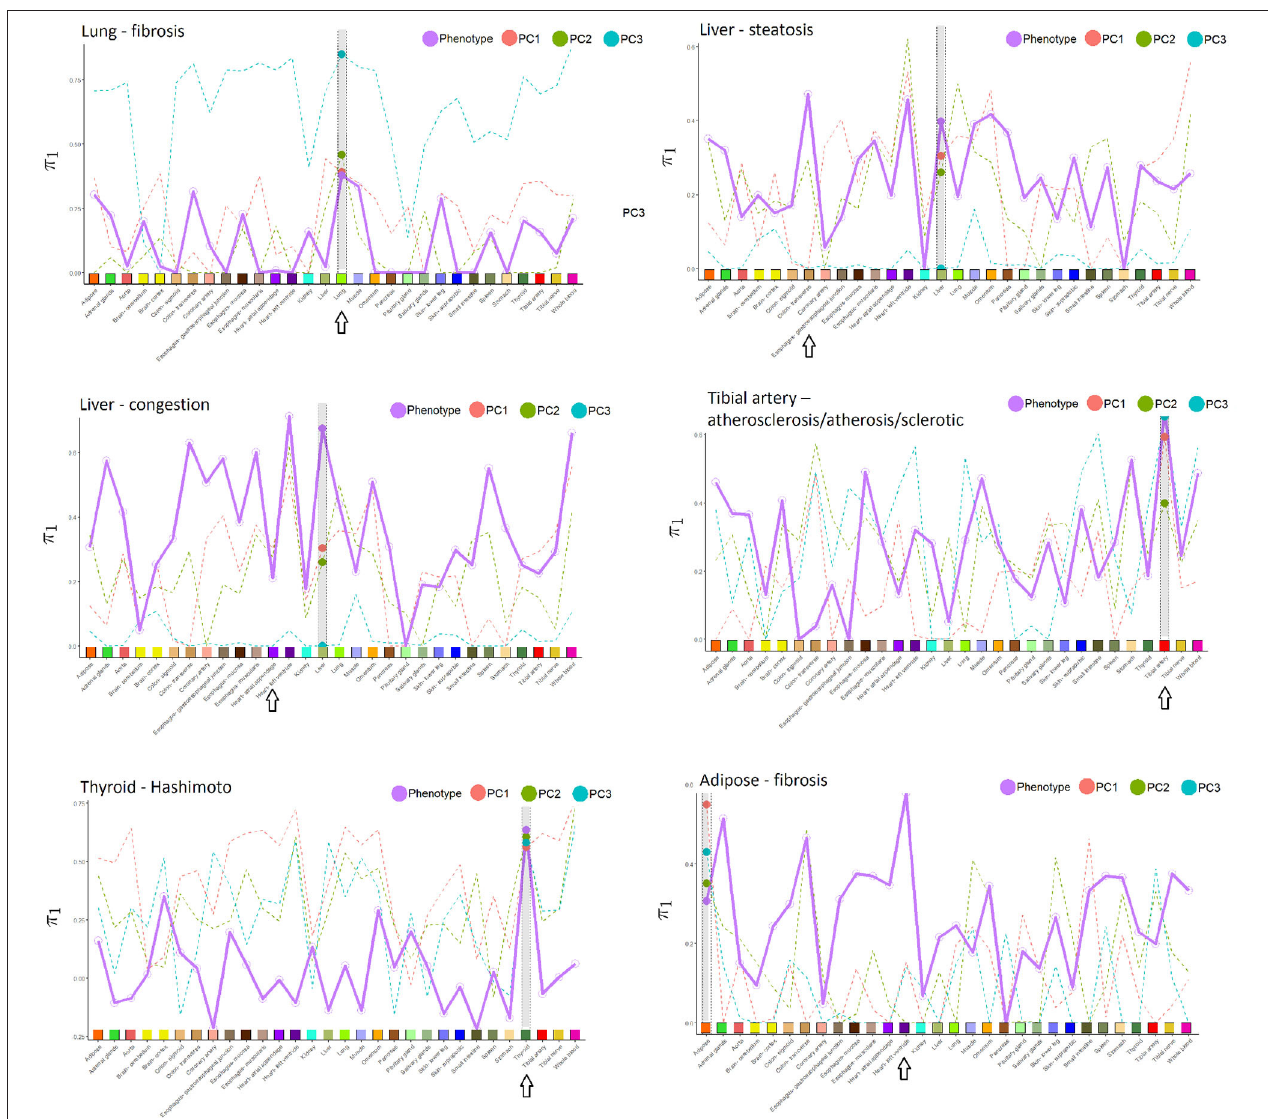
FIGURE 3 | Proportion of non-null p -values ( π 1 ) in the cross-tissue regression analysis of pathology phenotype vs. gene expression, and for image PCs 1–3 vs. expression. Larger dots are the π 1 values corresponding to the same tissue in which pathology was determined, which is also highlighted in gray in each subfigure. Arrows indicate the tissue with the highest π 1 for phenotype, in many instances coinciding with the phenotype tissue. Tissues used in the cross-tissue analysis are labeled using the same color scheme used by GTEx Consortium et al.